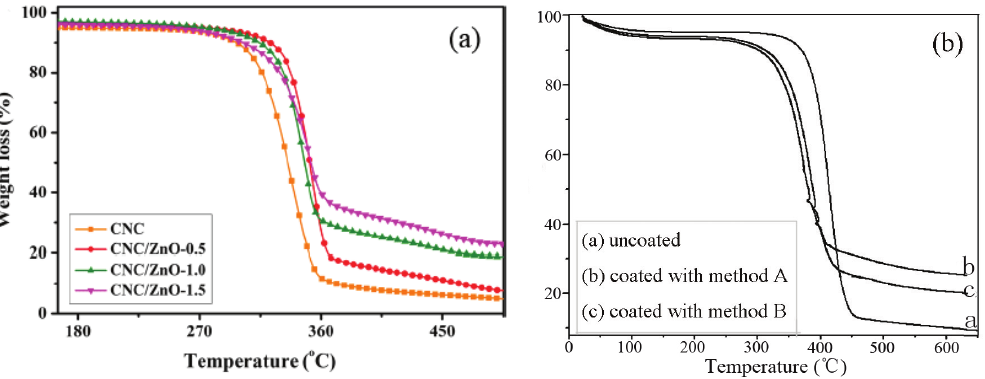
Figure 3: TG curves of cellulose/ZnO (a): the thermal stability increased compared to cellulose [79]; (b): the thermal stability reduced compared to cellulose